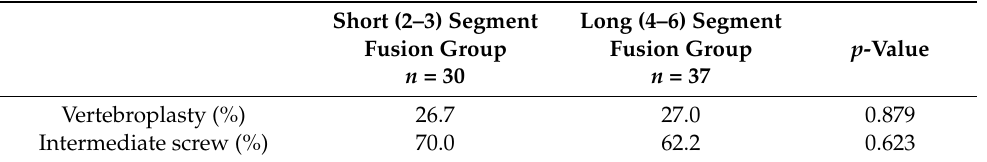
Table 3. Correlation between the number of fixed intervertebral segments and vertebroplasty or Intermediate screw